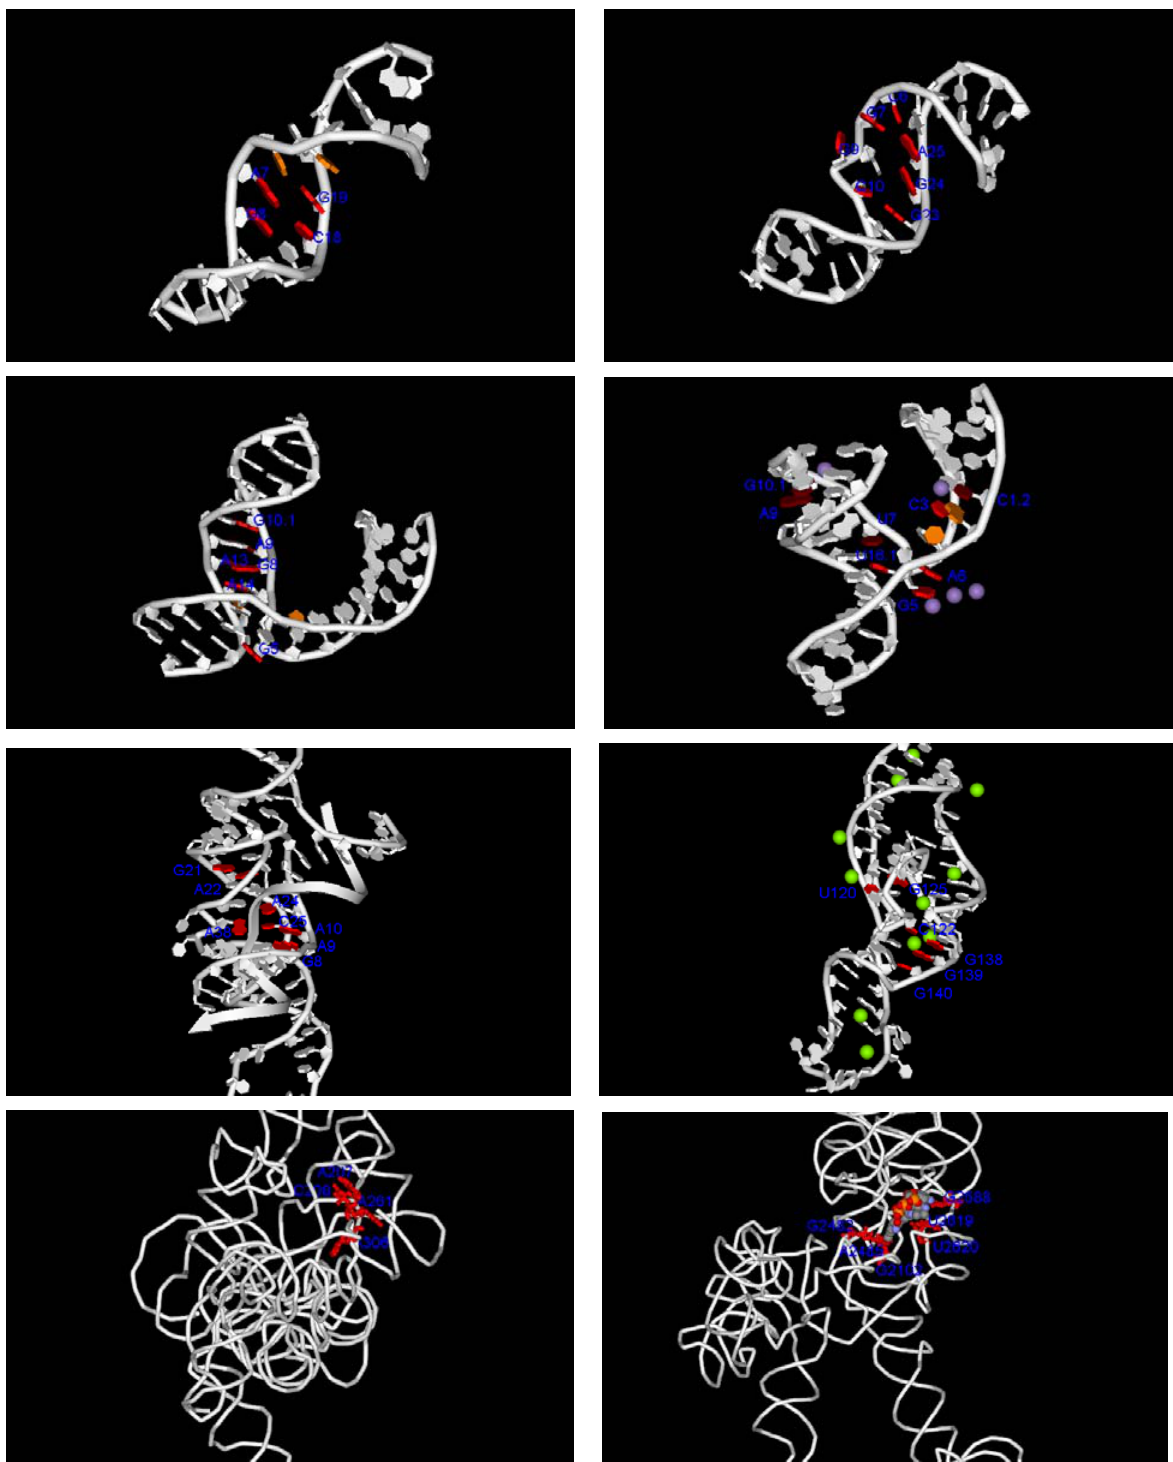
FIGURE 1 . Active site regions in the ribozymes analyzed in this study. Known catalytic nucleotides (red), cleavage sites (orange), and metal ions (spheres) are shown. Nucleotides are numbered according to the original papers. The slides were made with WebLab Viewer (MSI corp, CA, USA; http://www.msi.com). (a) PDB 1e4p, "hairpin"; (b) PDB 1ldz/2ldz, leadzyme; (c) PDB 1hmh, "hammerhead", substrate strand is shown; (d) PDB 300d, "hammerhead", metal-binding nucleotides are in dark red; (e) PDB 1m5k, "hairpin", substrate strand is shown as a ribbon; (f) PDB1cx0, HDV ribozyme, role of the metal ions in the catalysis is not known; (g) PDB 1grz, group I intron, putative active site region is shown; (h) PDB 1fg0, catalytic core of 23S ribosomal subunit, a substrate analog is shown.